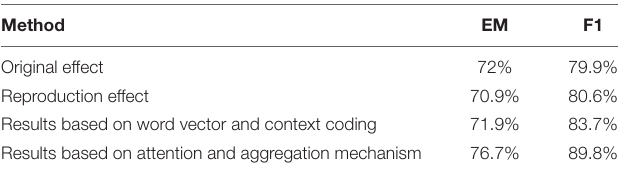
TABLE 8 | Comparison of experimental results based on attention and aggregation